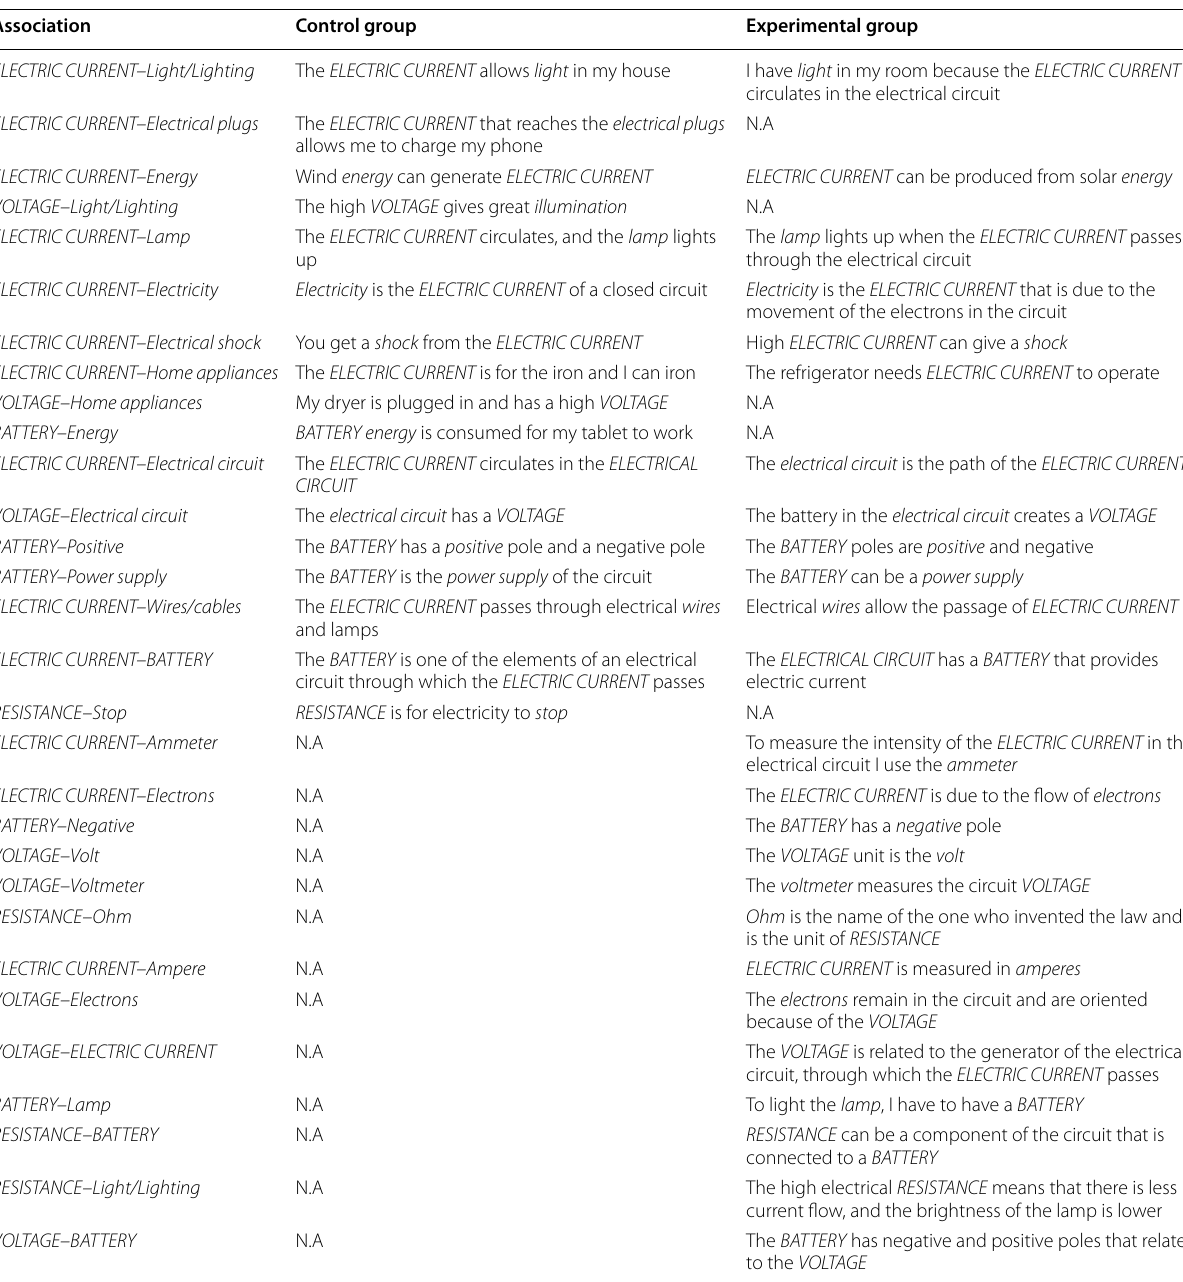
Table 6 Some representative sentences written by students at